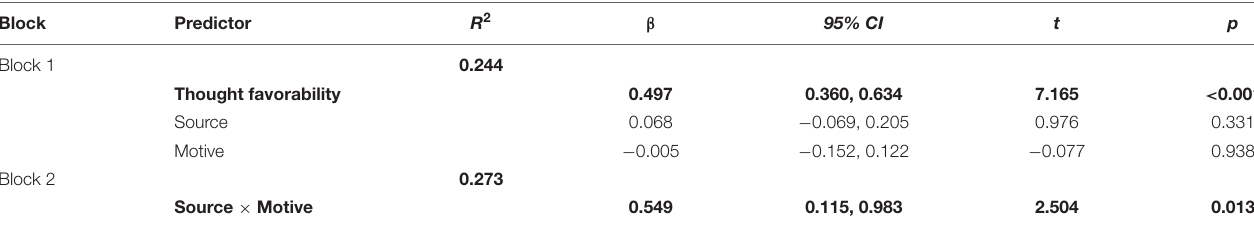
TABLE 1 | Multiple regression of product attitude on thought favorability, source condition, motive condition, and the source-by-motive interaction in study 2. Block Predictor R